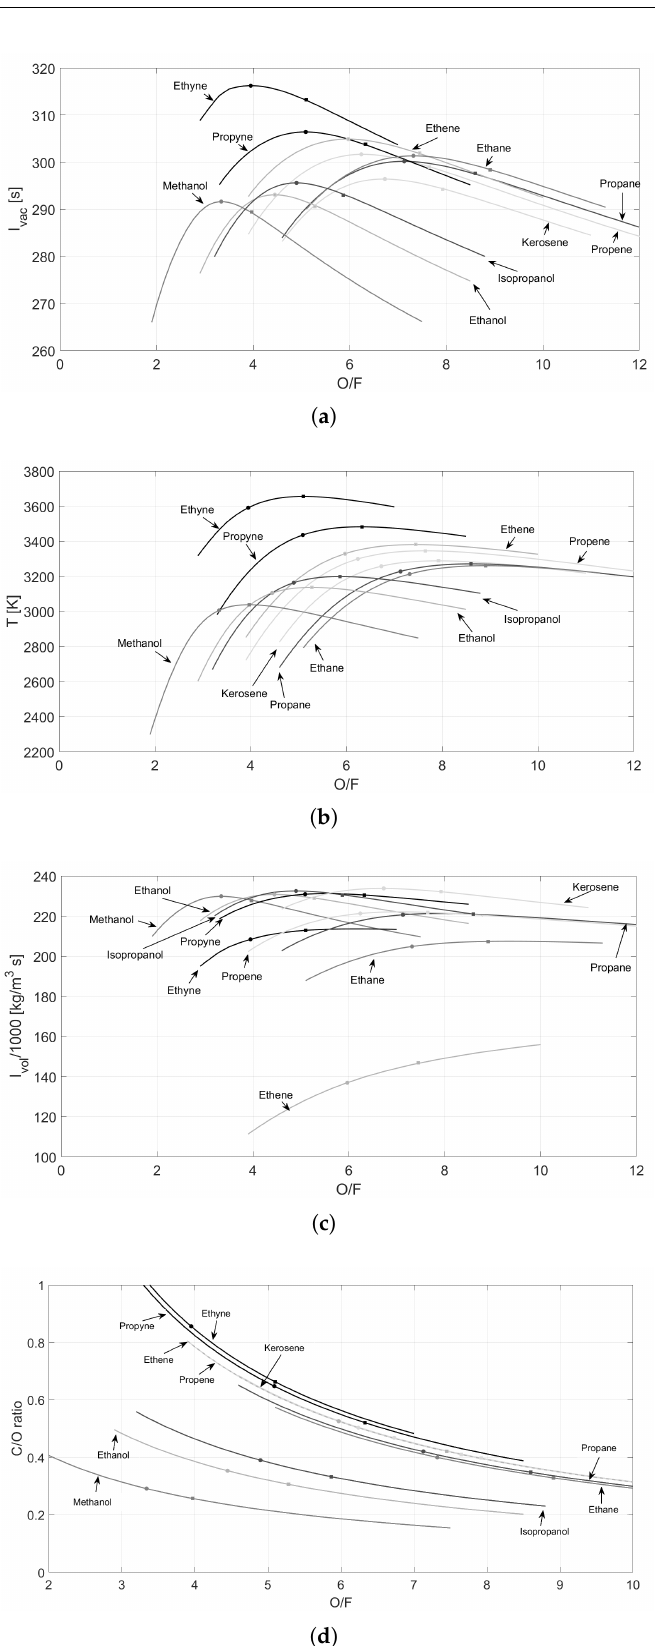
Figure 3. Nitrous Oxide-based propellants performances: ( a ) vacuum specific impulse; ( b ) chamber temperature; ( c) density impulse; and ( d ) C/O